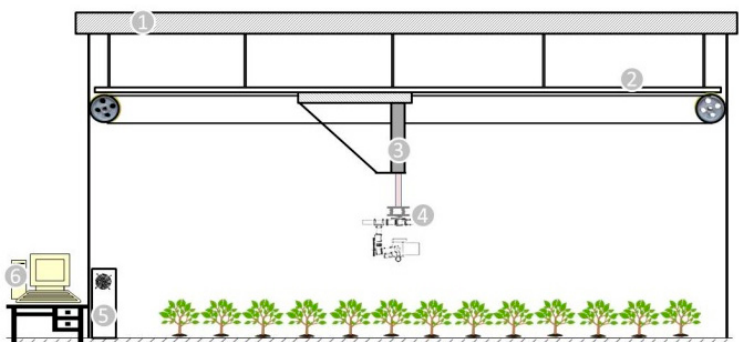
Figure 1. 1 is the ceiling; 2 is the guideway made by three 4 m long linear rails; 3 is a vertical actuator; 4 is the gimbal with a camera on it; 5 is the central controller; 6 is a computer with the upper machine software.